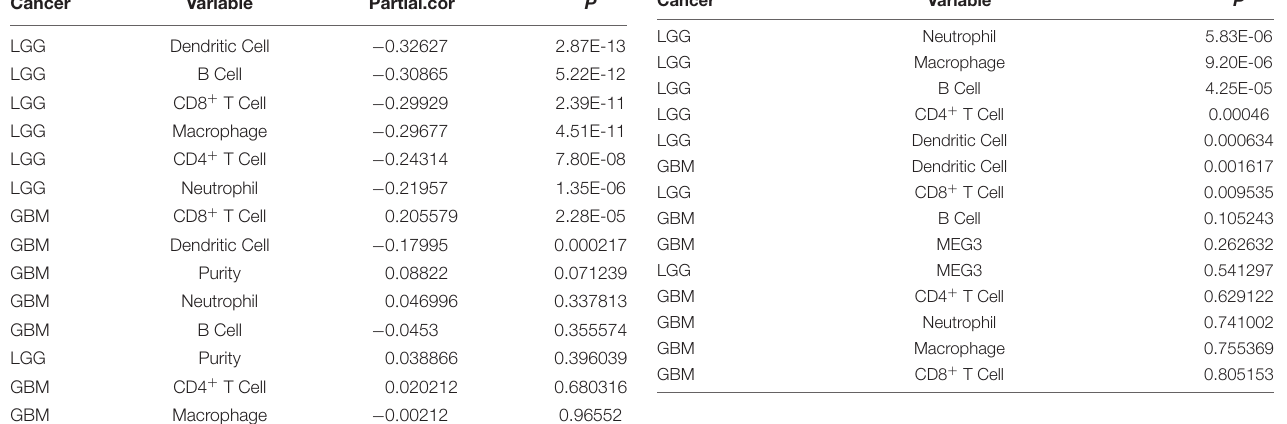
TABLE 1 | MEG3 expression associated with immune infiltration level in GBM and LGG. Cancer